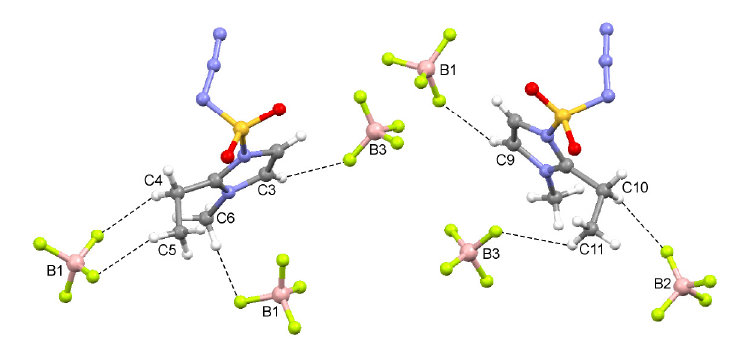
Figure 3. The components of 2 engage in short interionic C–H...F contacts.